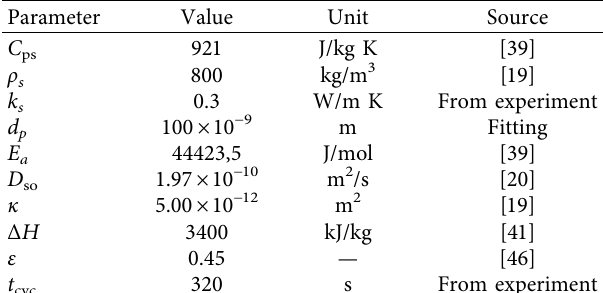
Table 3: Thermophysical properties of the working pair and simulation parameters.